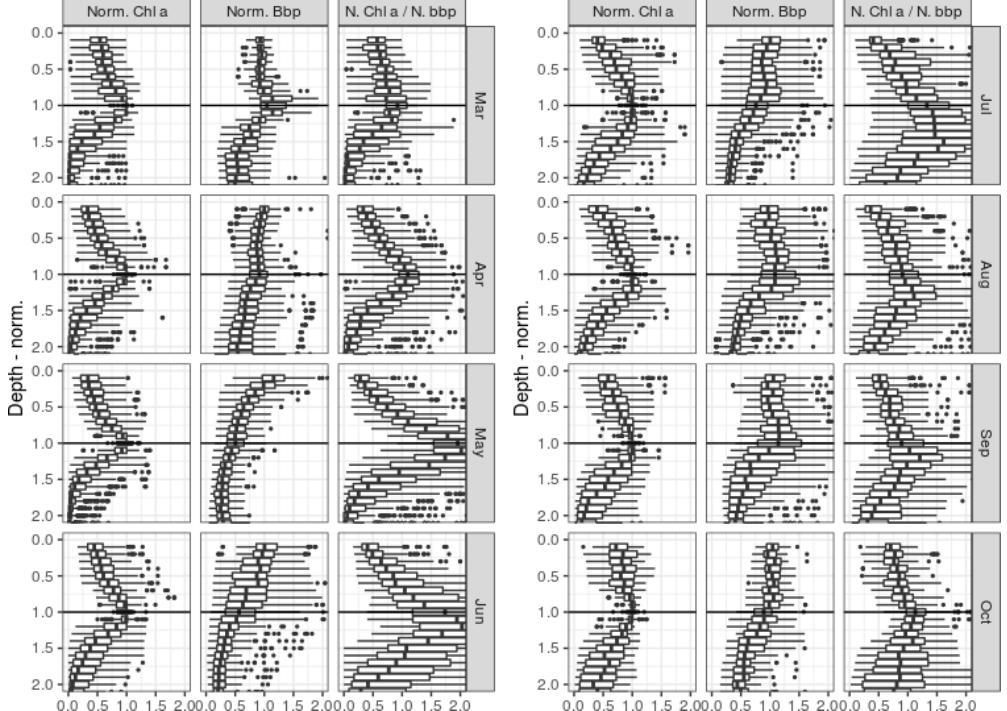
Figure 7. Distribution of normalized chl a and BBP values for different layers of normalized depth. The depth is normalized for each profile so that values of 1 and zero correspond to the depths of DCM and MLD, respectively (see Sect. 2.6 for the normalization procedure).